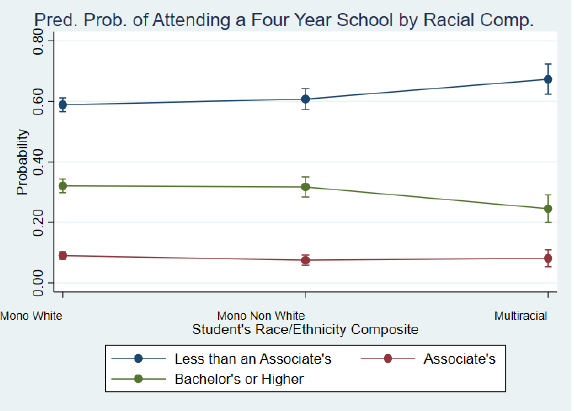
Figure 8. Pred. Prob. of Degree Attainment by Racial Comp. using ELS data.